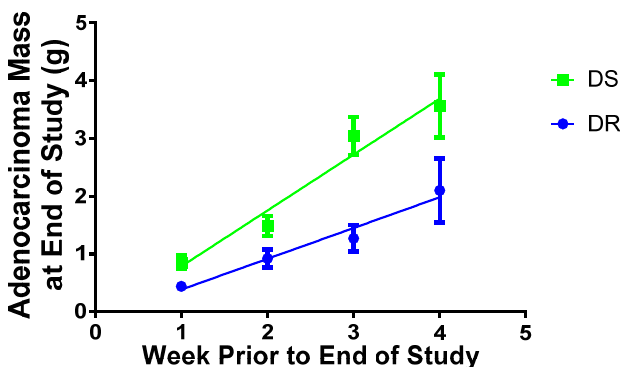
Figure 2. Estimation of tumor growth rates in dietary obesity sensitive (DS) and dietary obesity resistant (DR) rats. Week Prior to End of Study: a value of 0 is the end of study; week 4 indicates the tumor was detected 4 weeks prior to the end of study and had a longer timeframe during which to grow than tumors detected 3, 2, or 1 week prior to the end of study. Values are means ± SEM, n = 259 DS and 143 DR mammary carcinomas. The regression coefficients for each line (slope): DR 0.533 ± 0.070 g/week; DS 0.968 ± 0.140 g/week, p < 0.01.